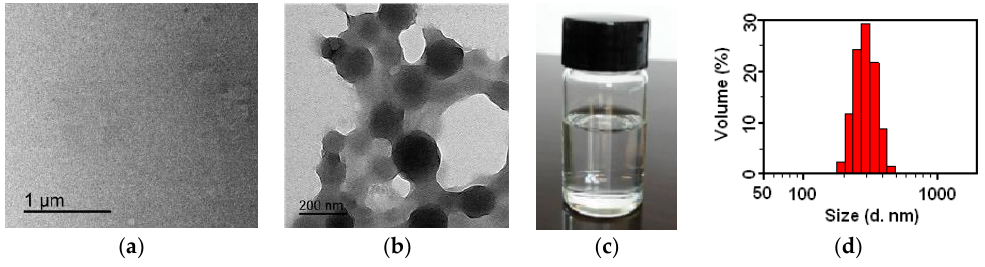
Figure 3. FVPS and FSi@SiO 2 resin: ( a ) TEM photograph, FVPS; ( b ) TEM photograph, FSi@SiO 2 ; ( c ) resin state, FSi@SiO 2 ; and ( d ) particle size distribution, FSi@SiO 2 .